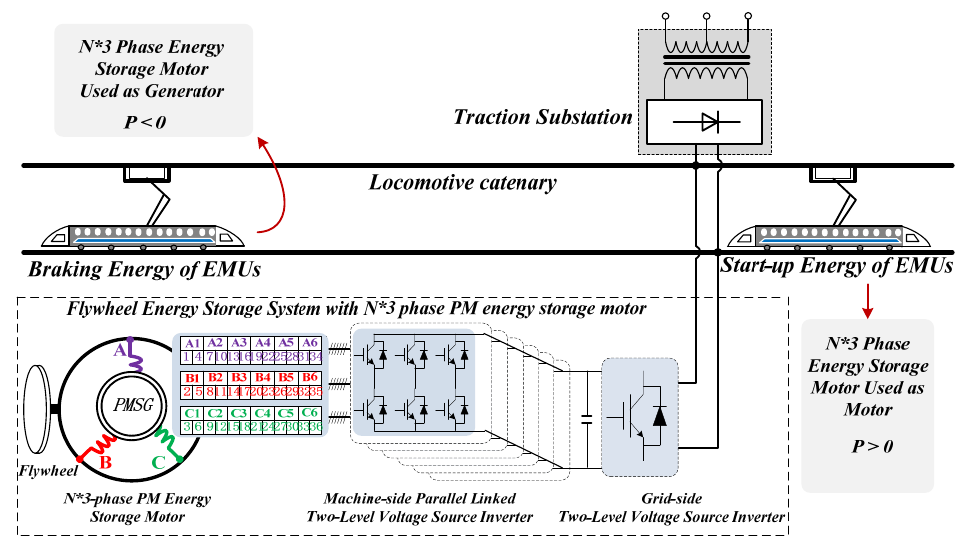
Figure 2. Topological structure of the N *3-phase PMSM system for ground rail transit.